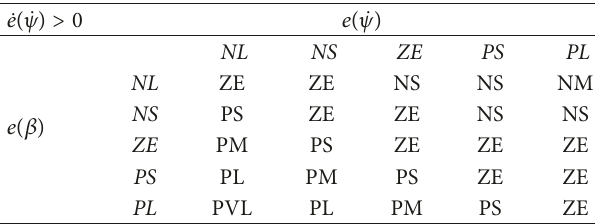
Table 4: Rules for positive yaw rate error derivative.